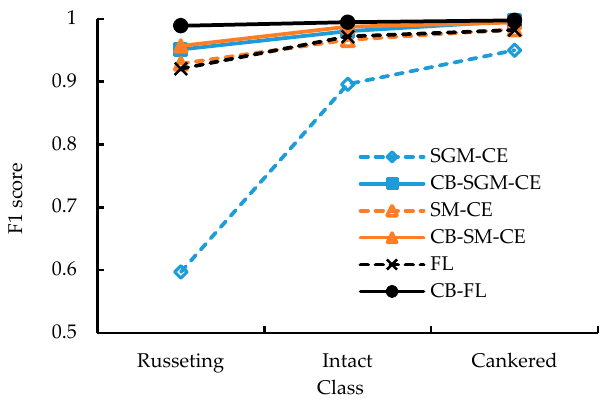
Figure 7. Recall using different loss functions.